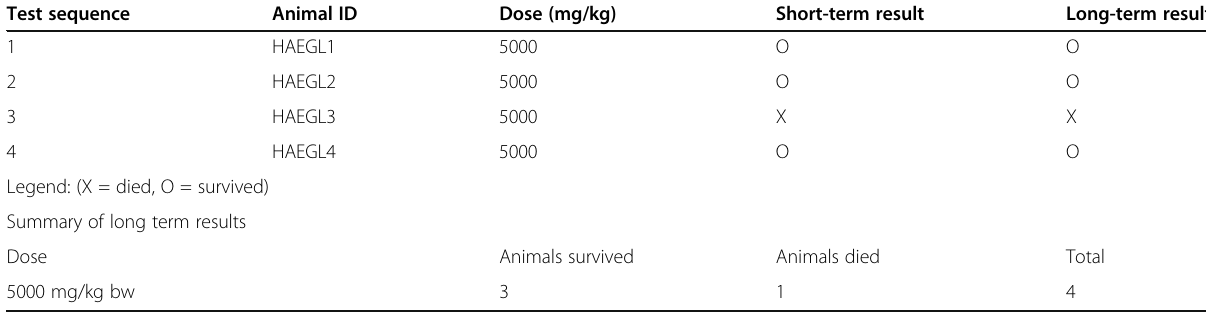
Table 1 Results of limit test for HAEGL conducted using AOT425 Statistical Program Test sequence